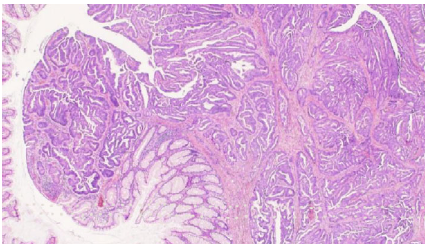
Figure 5: Left hemicolectomy. Moderately di ff erentiated adenocarcinoma of the large